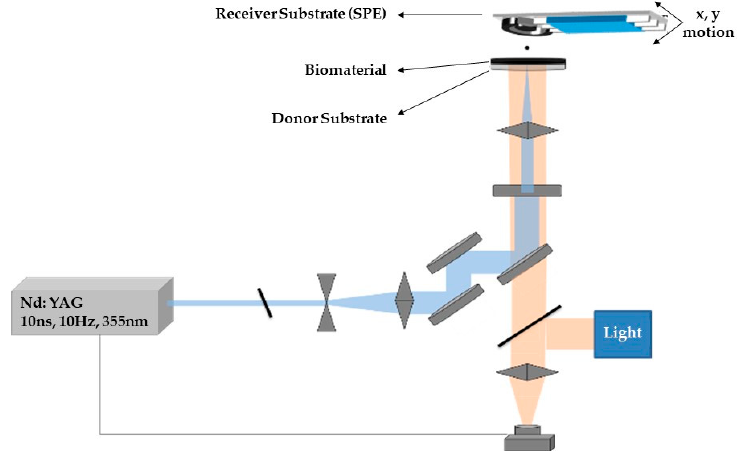
Figure 11. Schematic representation of the laser induced forward transfer (LIFT) experimental setup.